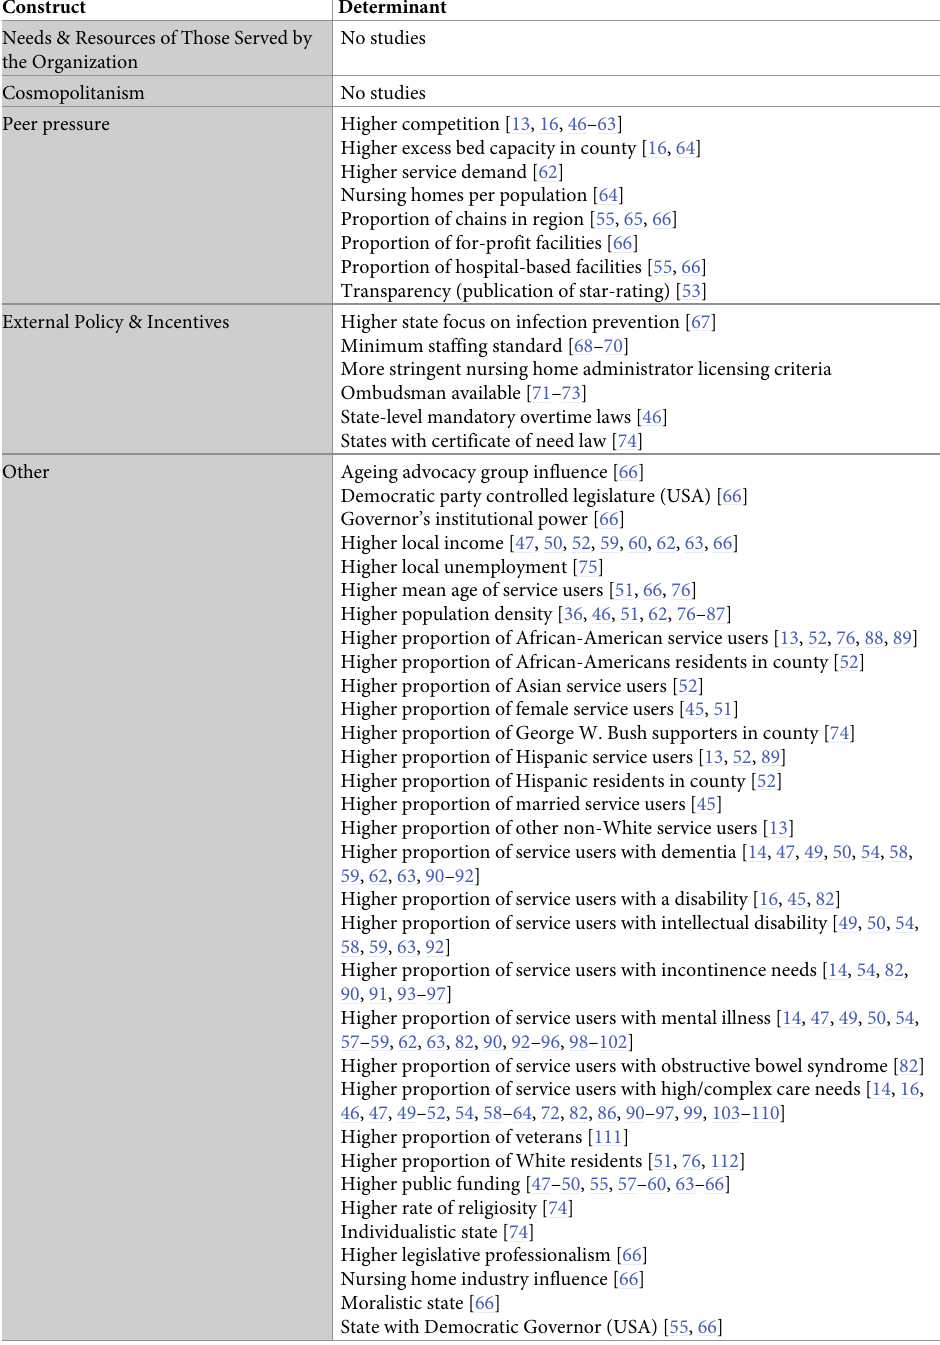
Table 3. Determinants coded to the outer setting